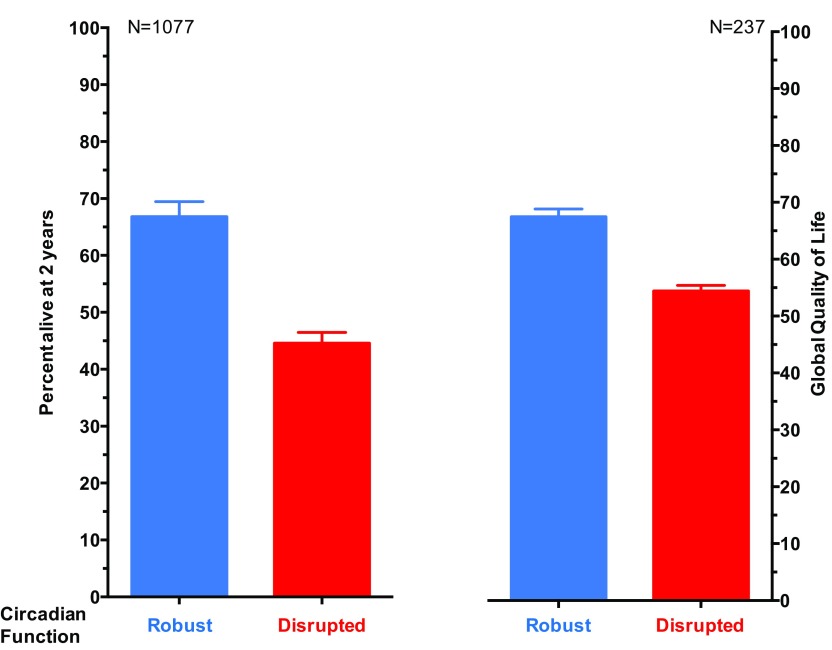
Main outcomes of cancer patients according to circadian functioning status, estimated through assessment of rest-activity or salivary marker rhythms. Left panel: estimated 2-year survival rate (mean + 95% confidence limit) in a total of 1077 cancer patients (Cohen et al., 2012; Innominato et al., 2012; Lévi et al., 2014; Schrepf et al., 2015; Sephton et al., 2013; Sephton et al., 2000). Right panel: global quality of life domain (mean + standard error of the mean), derived from the EORTC QLQ-C30 questionnaire, completed by a total of 237 patients with mCRC (Innominato et al., 2009b).